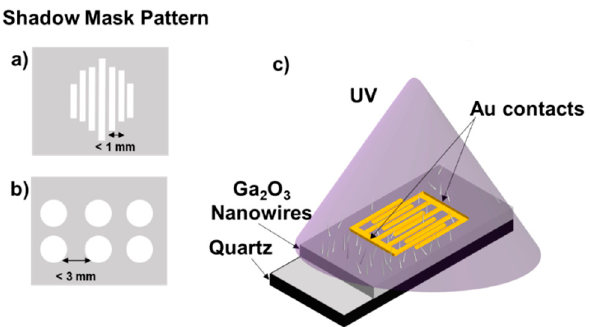
Figure 2. Schematic illustration of different shadow masks ( a , b ) used for sputtering 5 nm Cr and 50 nm gold (Au) contacts on Au/ β -Ga 2 O 3 /Au metal–semiconductor–metal (MSM) photoconductor on quartz. ( a ) The distance between the lines is <1 mm. ( b ) The distance between the circle probes is <3 mm. ( c ) Schematic illustration of Au/ β -Ga 2 O 3 /Au metal–semiconductor–metal (MSM) photoconductor on